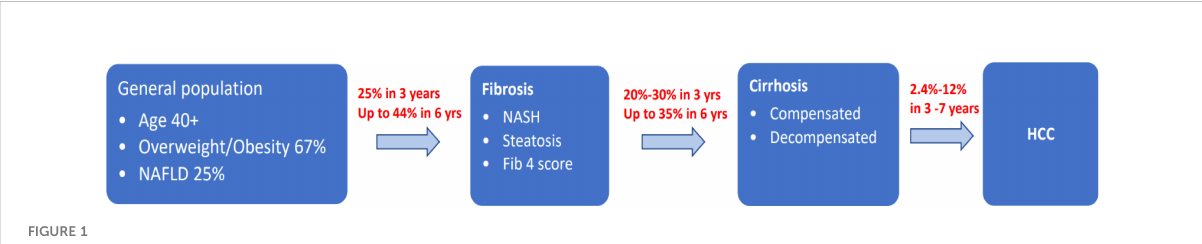
FIGURE 1 Conceptual model for progression from metabolic dysfunction, NAFLD, NASH, Cirrhosis and